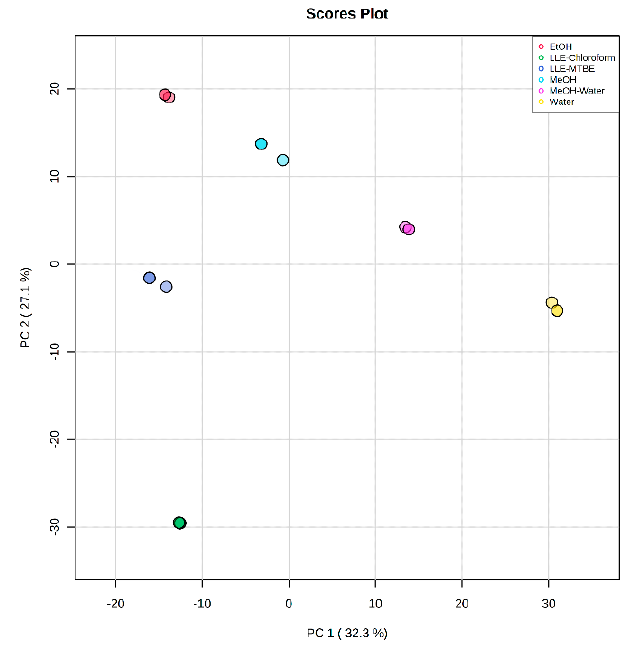
Figure 4. Principle component analysis (PCA) scores plot of pre-processed untargeted features ( n = 2176) measured in the different fecal extraction procedures ( n = 3 replicates).